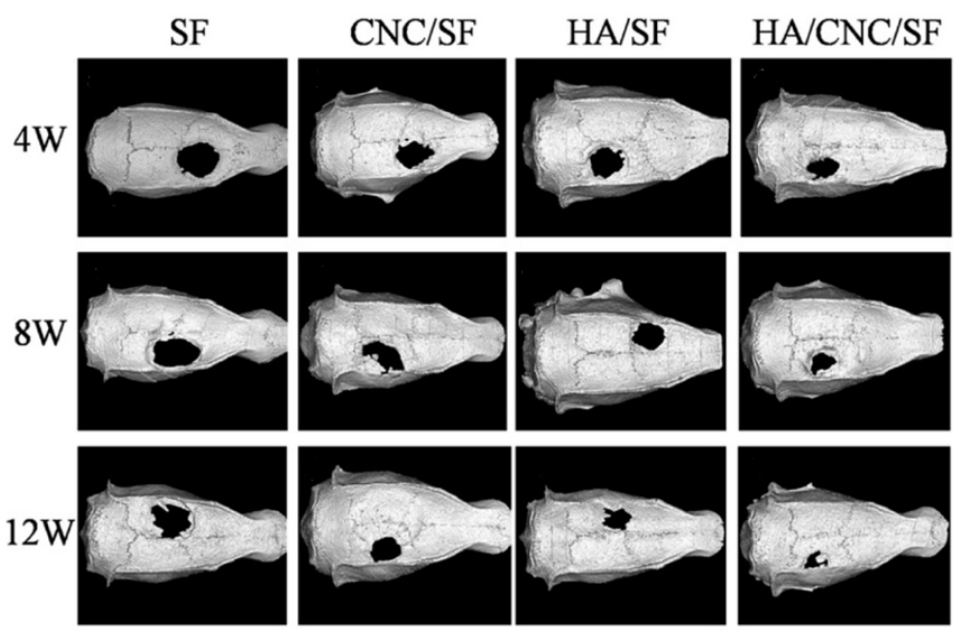
Figure 9. Illustration of the different repair results in rat calvarial defects assessed by micro-CT. Reproduced with permission from [118], 2011, Royal Society of Chemistry.